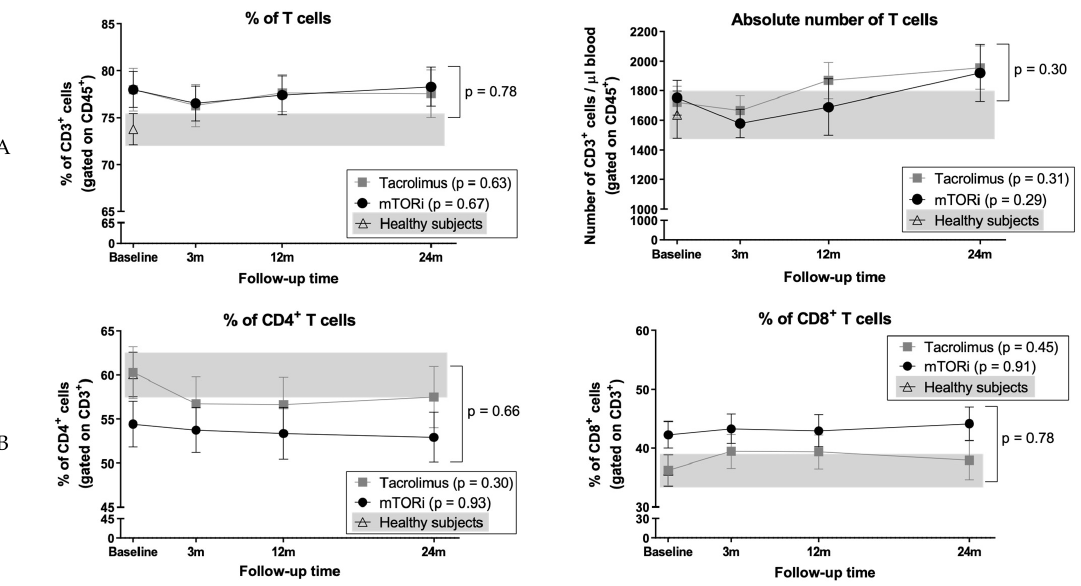
Figure 1. Evolution of T cells after switching from tacrolimus to serine/threonine protein kinase mechanistic target of rapamycin inhibitors (mTORi). Immunophenotyping of ( A ) total T cells and ( B ) CD4 + and CD8 + T cell subpopulations was carried out in patients before and after switching to mTORi (black dots) and in patients maintaining tacrolimus (grey squares). Healthy subjects (HS) data is depicted with white triangles, and the grey background corresponds to range. Plots show mean and standard error of the mean (SEM) for each time point.